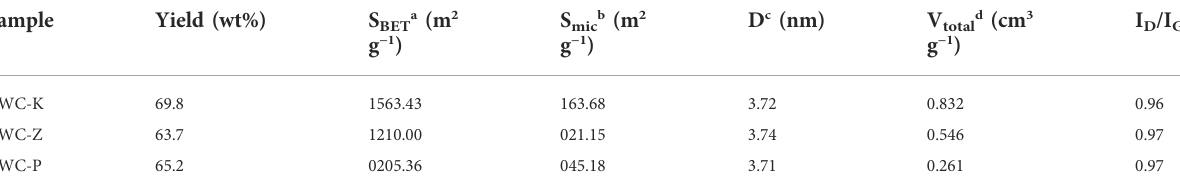
TABLE 1 Yield, Textural parameters, and raman tests of samples.